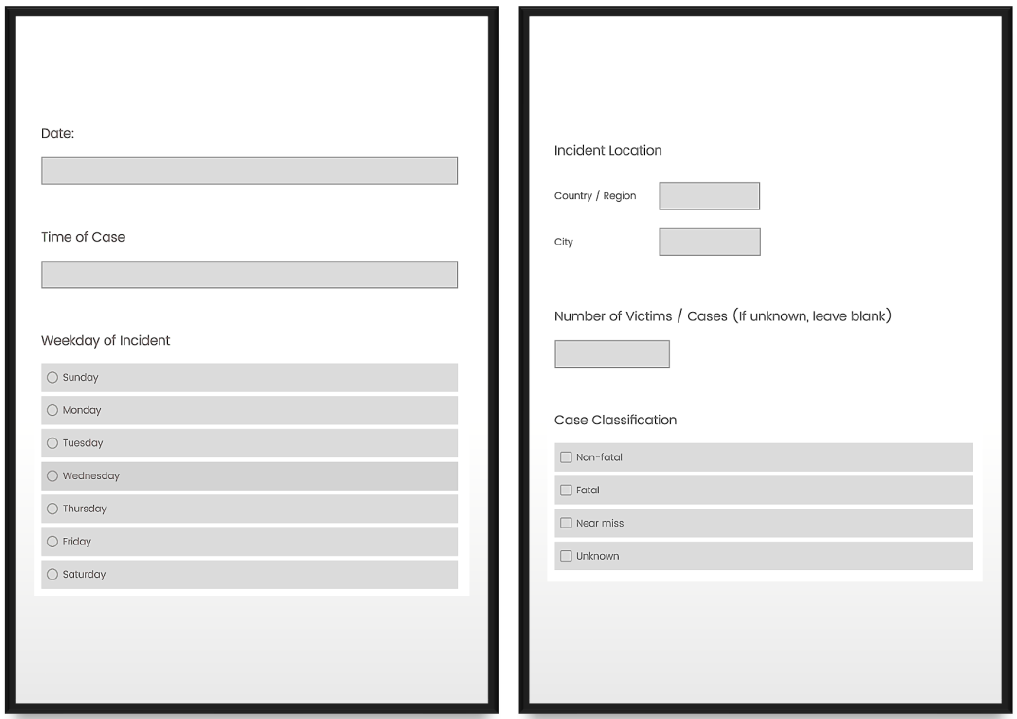
Figure 3. Qualtrics Survey Form: Date, Time, Day, Location, Victims, Class.